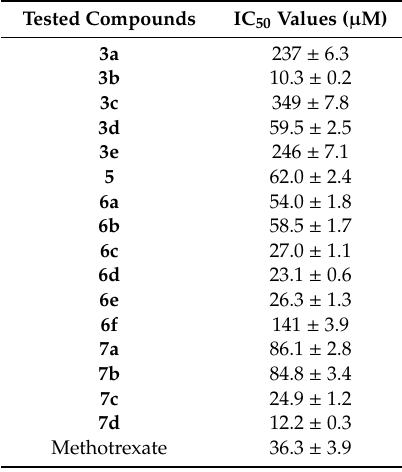
Table 1. In vitro inhibitory activity of tested compounds against the human Lung carcinoma cell line (A549) expressed as IC50 values µ M ± standard